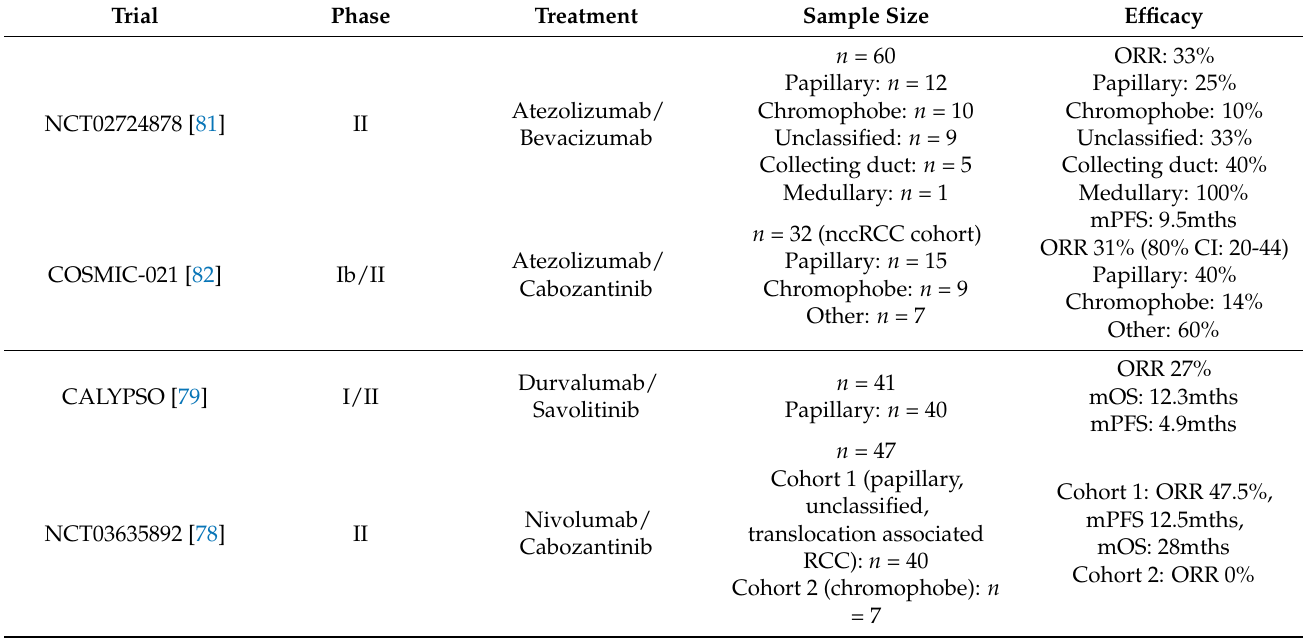
Table 6. Completed single arm studies of IO plus targeted therapy in nccRCC [78,79,81,82]. Trial Phase Treatment Sample Size